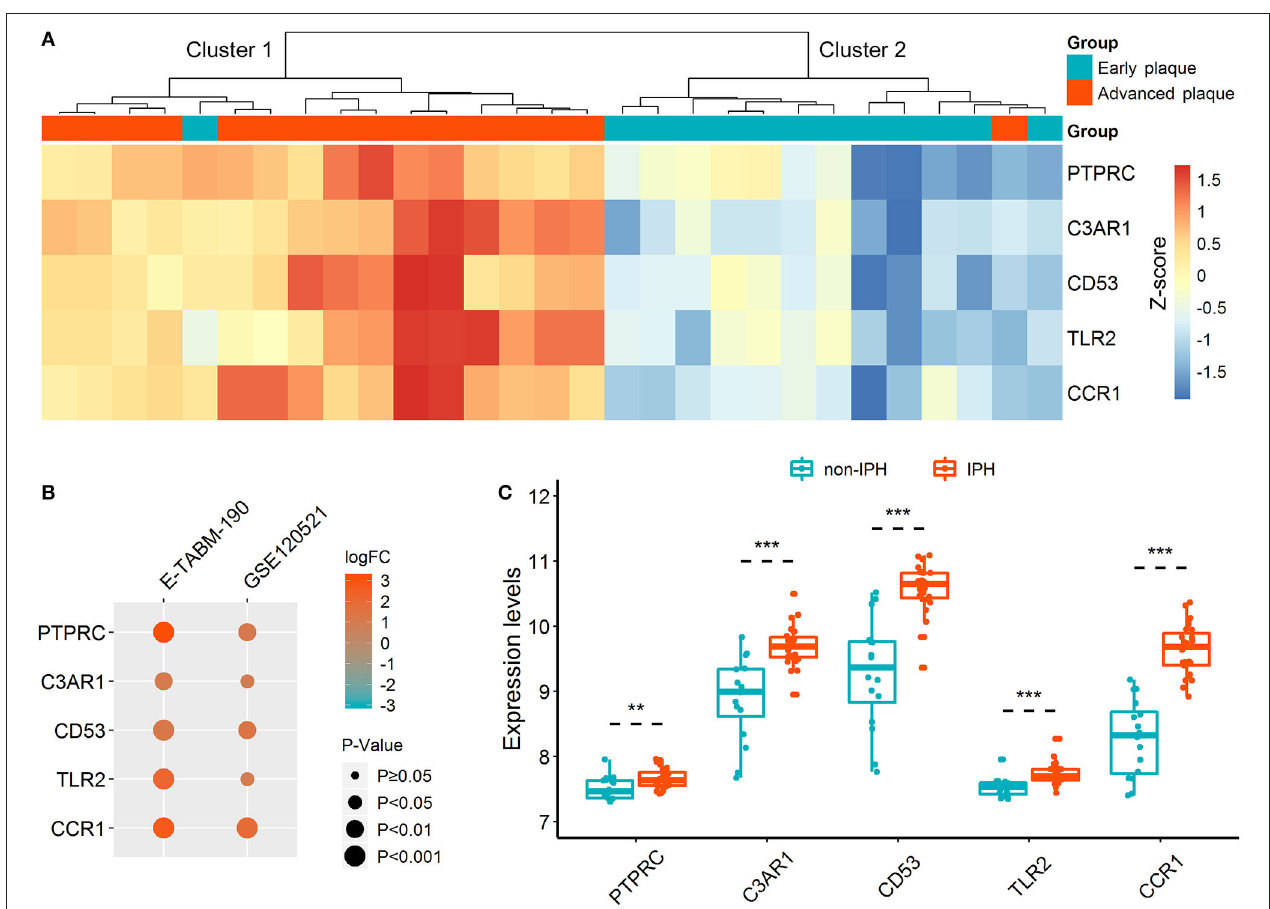
FIGURE 3 | Expression patterns of hub DETregRGs between advanced and early atherosclerotic plaques. (A) The heat map for unsupervised hierarchical clustering of the five hub DETregRGs in GSE28829 dataset. (B) Validation of the hub DETregRGs between stable and unstable atherosclerotic plaques. (C) Validation of the hub DETregRGs between atherosclerosis with and without IPH. ** p < 0.01, compared with the non-IPH group; *** p < 0.001, compared with the non-IPH group. DETregRGs, differentially expressed Tregs-related genes; FC, fold change; IPH, intraplaque